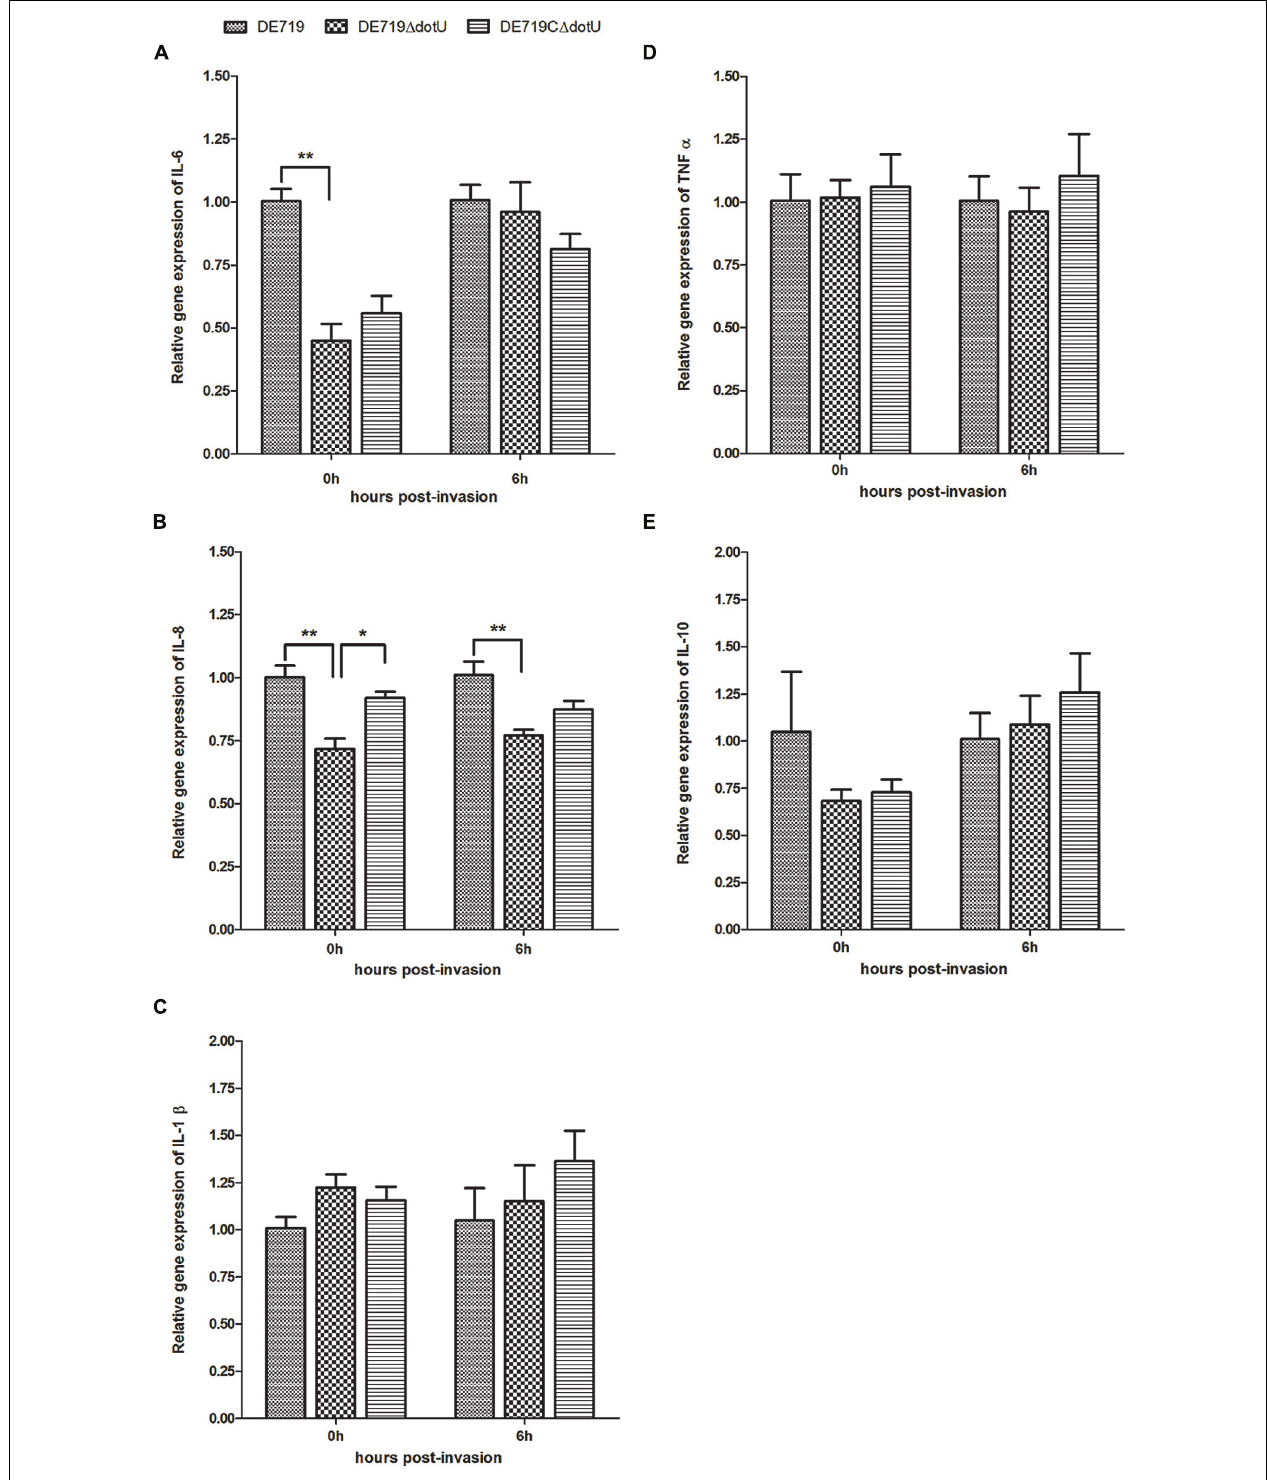
FIGURE 8 | Cytokine expression in the HD-11 cells infected with APEC bacteria. Expression of IL-6 (A) , IL-8 (B) , IL-1 β (C) , TNF α (D) and IL-10 (E) in infected HD-11 cells was analyzed by RT-PCR, normalized to β -actin gene. Samples were calibrated to gene expression in DE719 infected HD-11 cells. Expression of IL-6 and IL-8